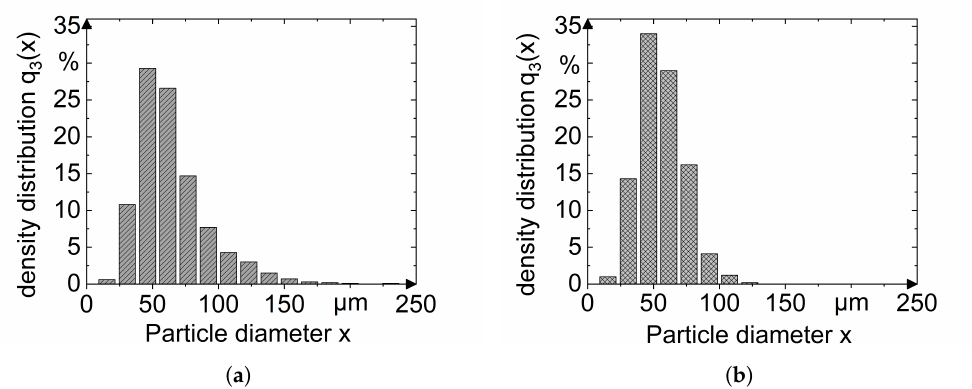
Figure A3. Particle size distribution of ( a ) the PMMA and ( b ) the Al 2 O 3